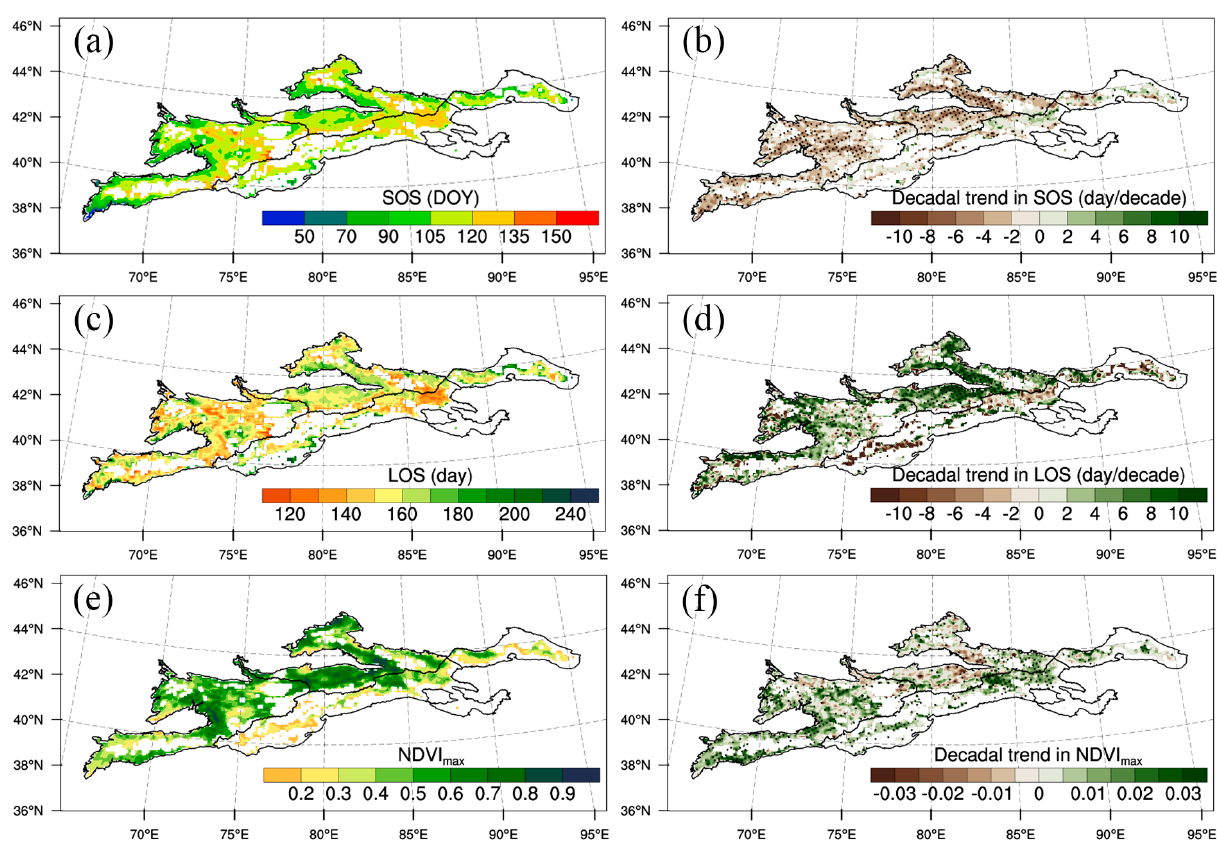
Figure 2. Spatial distribution of the mean vegetation metrics (left panels) and their trends (right panels) from 1983 to 2015 (SOS ( a ) and ( b ), LOS ( c ) and ( d ), and NDVI max ( e ) and ( f )). The white space in Figure 2 means no data, and the black dots in ( b , d , f ) indicate the trend at a 0.05 significant